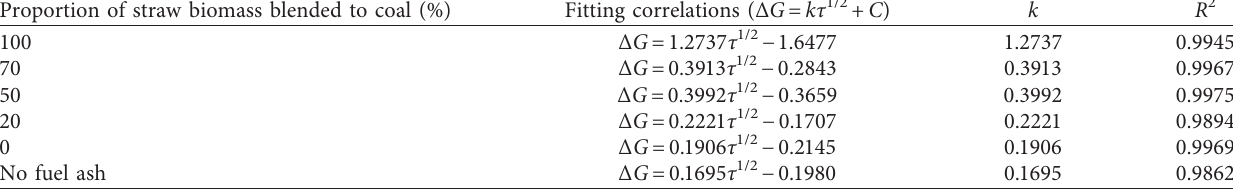
Table 5: Fitting correlations of corrosion mass gain under different proportion of straw biomass blended to coal for metal samples coated with ash.